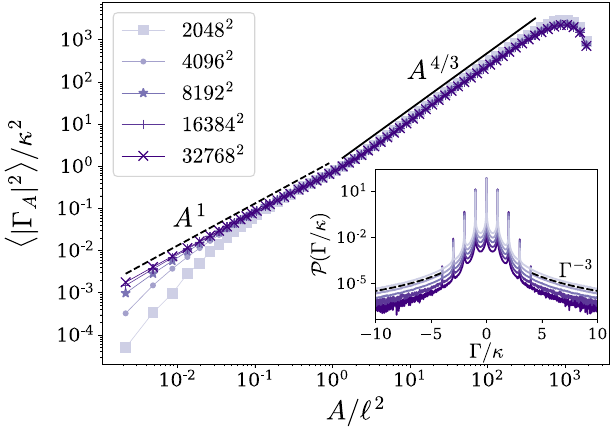
FIG. 7. Momentsoforder2fordifferent valuesoftheresampling in gGP simulations with N 3 ¼ 2048 3 . Resampling factors are β ¼ 1 , 2, 4, 8, and 16. As the resampling increases, vortices are better resolved, and the expected scaling at small scales arises. At large scales, the system is less affected by resampling. Inset: probability distribution of the circulation for a loop size r= l ¼ 0 . 67 . Peaks are observed at small-circulation values which are multiples of κ . The separation between peaks and valleys is higher as the resampling increases. Tails exhibit a Γ − 3 r